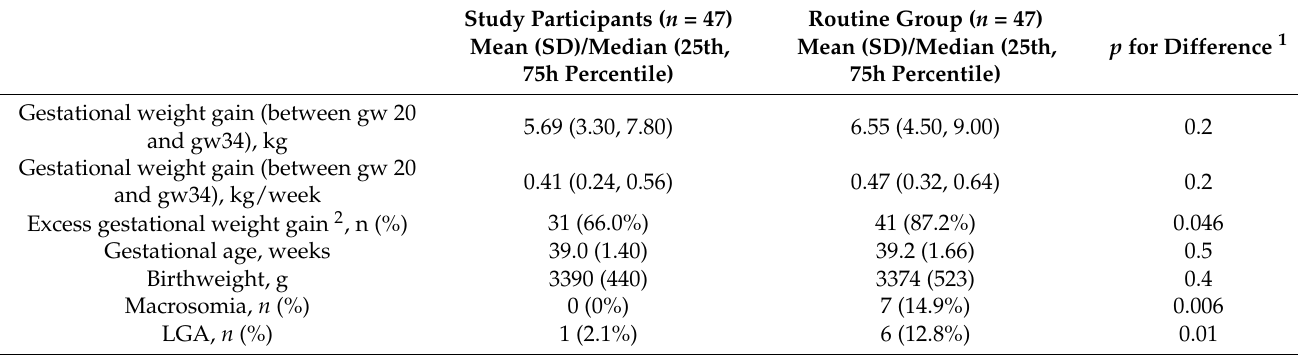
Table 5. Pregnancy outcomes comparing those women participating in the nutritional intervention study (combined) to propensity-score matched